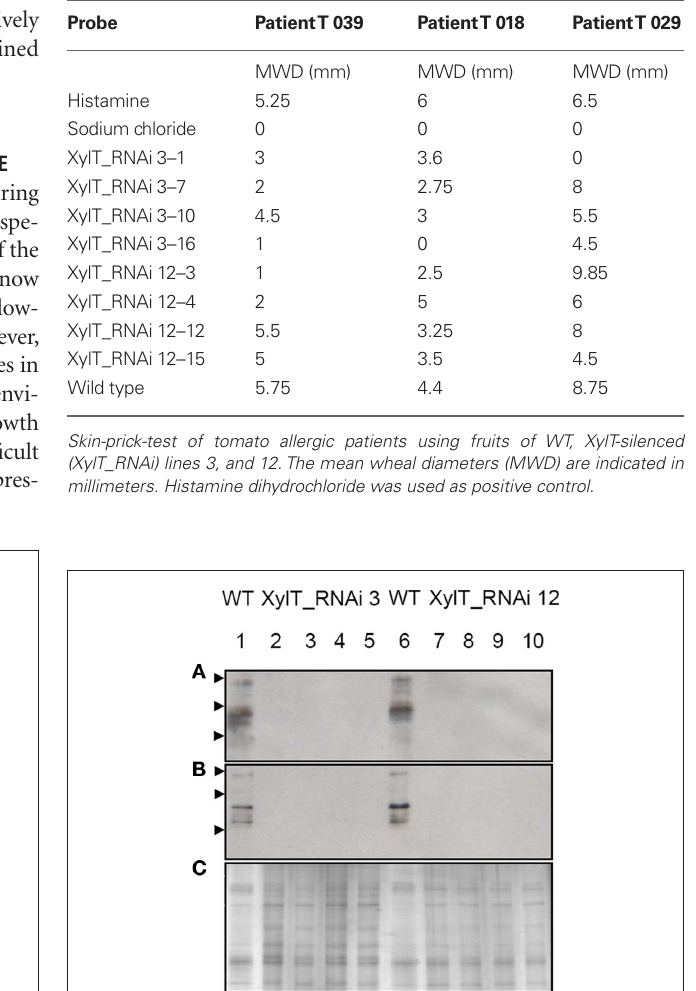
Table 2 | Skin prick tests with XylT-silenced tomato fruits.